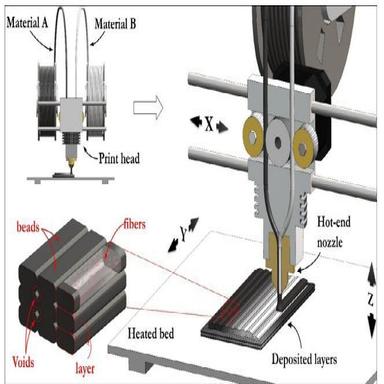
Process description of the multi-material fused filament fabrication process.